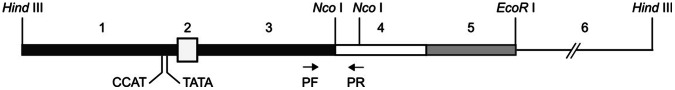
pCAgcGH structure diagram.1: carp β-actin gene 5′-flanking sequence; 2: carp β-actin gene first exon; 3: carp β-actin gene first intron; 4: grass carp GH gene sequence; 5: grass carp GH gene 3′-flanking sequence; 6: plasmid pUC118. PF and PR indicate PCR primers of transgenes.